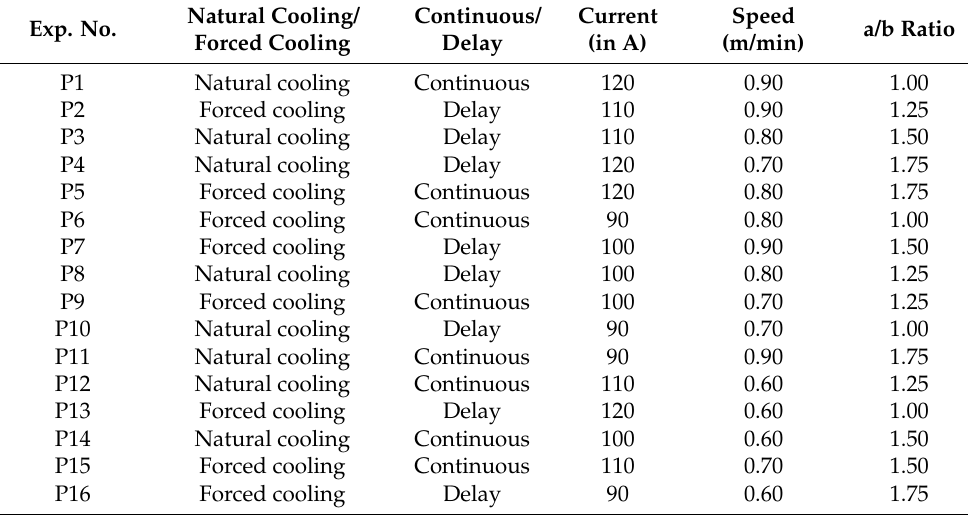
Table 4. DOE array for the experimentation on passive thermal